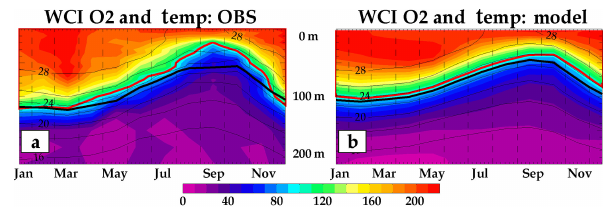
Figure 4. Seasonal evolution of oxygen (µmolL − 1 ; color shaded) and temperature ( ◦ C; thin black contour) vertical profiles aver- aged over the WCI box (indicated as black frame in Fig. 5) from (a) WOA13 and (b) model. The oxycline and thermocline depths are marked by thick red and black lines, respectively, in both pan- els.